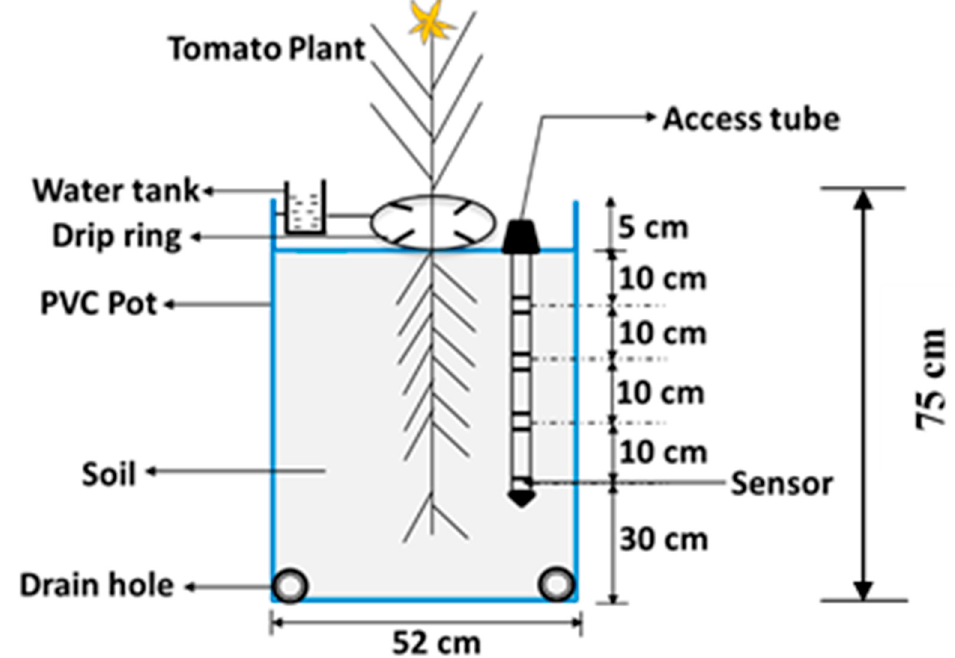
Figure 1. Layout of an experimental pot and details.